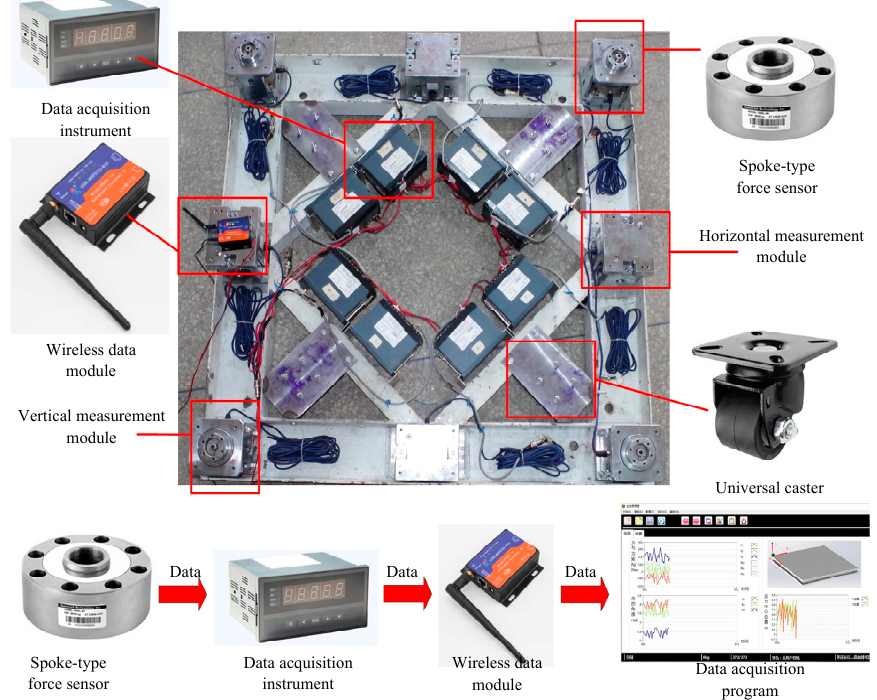
Figure 15. Internal components of the completed proposed six-dimensional force sensor used in the application experiments.